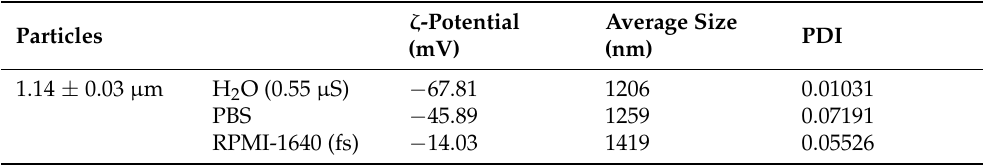
Figure 2. Snapshots of the simulations showing the entry of the plastic particle with a corona of 150 cholesterol molecules into the DOPC bilayer, a model blood–brain barrier (orange: hydrophobic moieties of the DOPC molecules; green: hydrophilic groups of the DOPC; dark grey: polystyrene; light grey: cholesterol). The nanoparticle approaches the membrane in the beginning of the simulation ( above ), and then spontaneously diffuses into its hydrophobic core, followed by the dissociation of its corona, and the disentanglement of the polymer chains by the end of the 1 µs run (below). To underline these computational fi ndings of MNP uptake into the brain, we per- Table 1. Matrix-induced change of the zeta potential, average size and polydispersity index of 1 µ m formed short-term exposure experiments in mice with commercially available PS particles sized PS particles at pH 7.4 and 25 ◦ of 3 di ff erent sizes (9.55 µm, stained in blue; 1.14 µm particles stained fl uorescent red